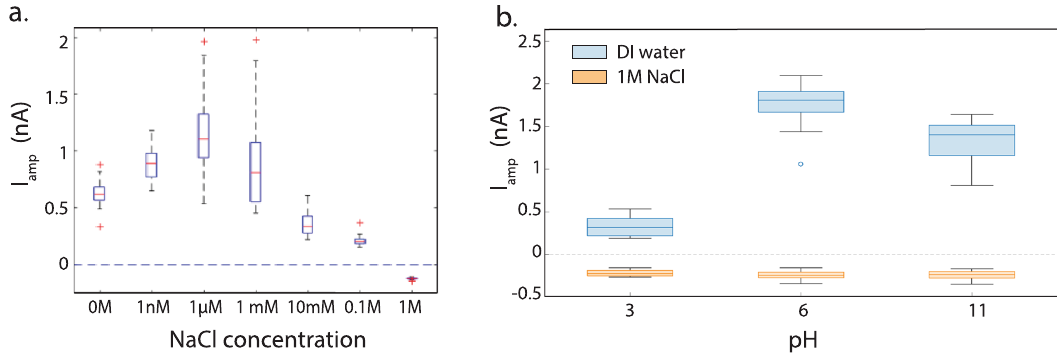
Fig. 5 Effect of liquid ’ s monovalent ion concentration and pH on electric signals generated after contact with C. antiquorum . a Boxplot showing the effect of NaCl concentration on the generated current amplitude. Each box represents 50 measurements recorded after previously 3000 droplets of the same solution have been dropped on the leaf. b Effect of pH on the generated current amplitude. The boxplot summarize 20 droplet impacts on C. antiquorum leaves for each ion concentration and (Supplementary Fig. 11). FTIR measurements (Supplementary Fig. 12) before and after wax removal con fi rmed a reduction of the vibrations at 1460 cm − 1 , 1470 cm − 1 , and 719 cm − 1 which